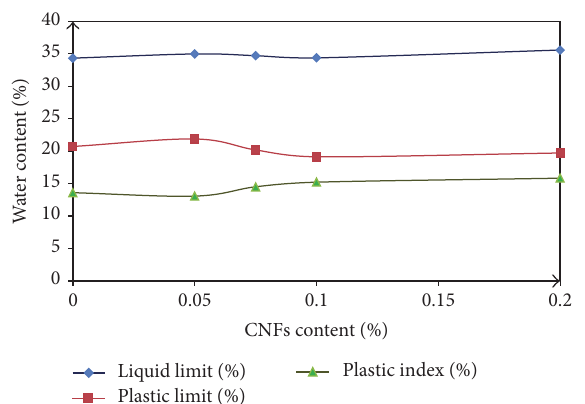
Figure 14: Effect of CNFs on LL, PL, and PI.